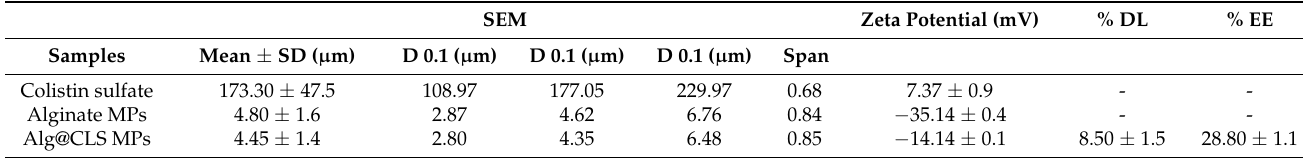
Table 1. Characterization of drug- and alginate-based microparticles (mean ± SD, n = 150). SEM